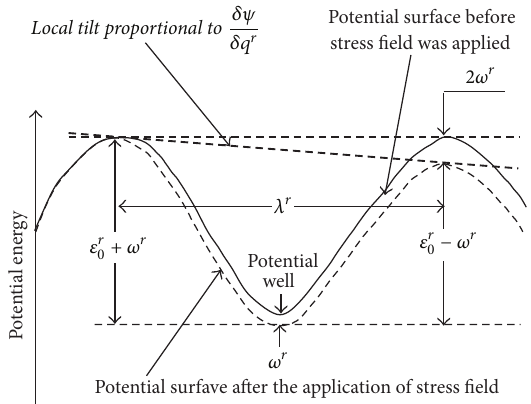
Figure 1: Energy barrier model of atomic